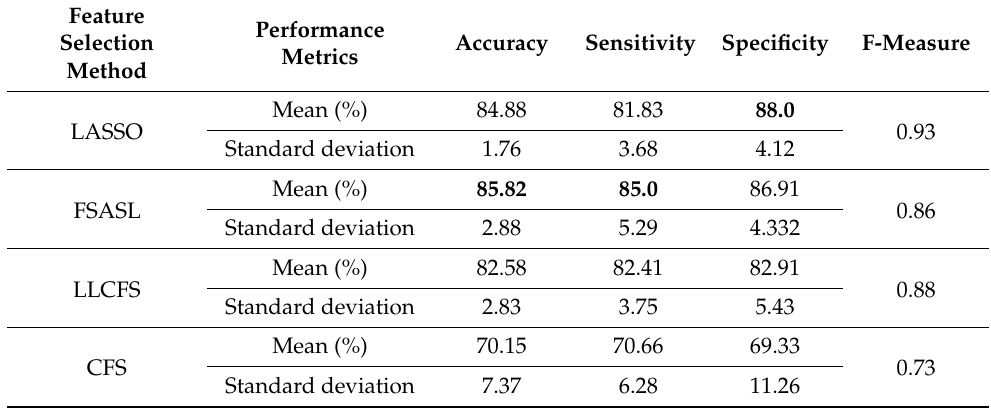
Table 8. Classification performance for AD against HC using SL-RELM classifier on Combined brain network using different feature selection methods.